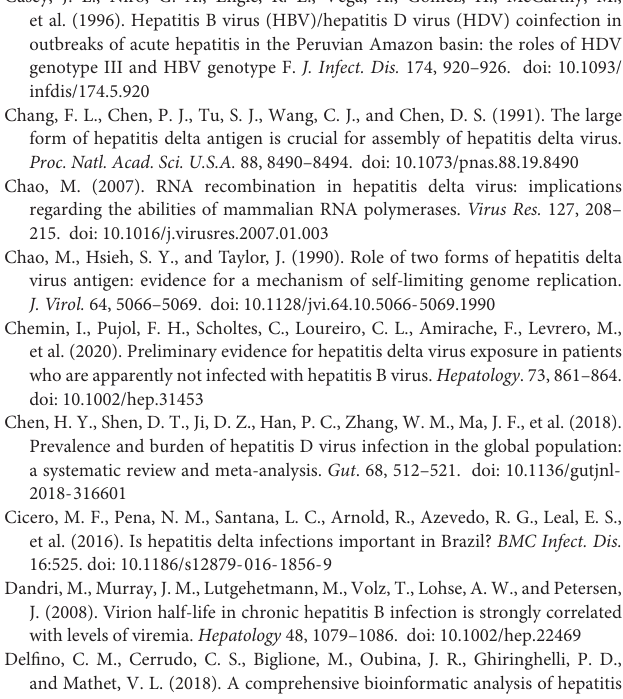
Displayed is the HDV amber/W site. The sequence ATG represents a stop codon and thus encodes for the S-HDAg, while RNA editing leads to the sequence ACC, which encodes for the L-HDAg. (C) Western blot analysis of intrahepatic S- (24 kDa) and L-HDAg (27 kDa) in two HBV/HDV-3 (left two lanes) and HBV/HDV-1 (right two lanes) infected mice. Supplementary Figure 3 | Cell death markers in mice co-infected with HBV and HDV-1cc or HDV-3cc. (A) qRT-PCR measurement of intrahepatic human caspase 8 (normalized to median of housekeeping genes hGAPDH and hRPL30) in HBV/HDV-1cc and HBV/HDV-3cc co-infected mice 9 weeks post infection compared to uninfected mice. The bar shows median levels. (B) Human serum albumin (ELISA) in HBV/HDV-1cc and HBV/HDV-3cc co-infected mice at different time-points of the experiment. Supplementary Figure 4 | Correlation of liver HDV RNA and hISG mRNA. qRT-PCR measurements of liver HDV RNA (normalized to housekeeping gene hGAPDH) and hISG15 or hCXCL10 (normalized to median of housekeeping genes hGAPDH and hRPL30) in HBV/HDV-3cc (red dots) and HBV/HDV-1cc infected mice (green dots) 9 weeks post infection. Correlations between HDV RNA and hISG15 or hCXCL10 show a p -value of p = 0.0323* (spearman r = 0.63) and p = 0.0591 (spearman r = 0.57), respectively, when HBV/HDV-1cc and HBV/HDV-3cc infected mice are analyzed together. Supplementary Figure 5 | Intrahepatic HLA ABC expression. Immunofluorescence staining of human HLA ABC (red), HBcAg (green), HDAg (turquoise) and overlays of HLA ABC with HBcAg or with HBcAg and HDAg in HBV/HDV-1cc (left) and HBV/HDV-3cc (right) co-infected mice at the end of the experiment. Nuclei are stained with Hoechst 33258 (blue). Supplementary Figure 6 | HBV in chronic HBV-infected mice simultaneously super-infected with HDV-1cc and HDV-3cc. qRT-PCR measurements of serum HBV DNA (quantification with plasmid standard) (A) and liver pregenomic HBV RNA (normalized to housekeeping gene hGAPDH) (B) in chronic HBV-infected mice simultaneously super-infected with HDV-1cc and HDV-3cc (red line or dots) compared to stable HBV mono-infected mice (black line or dots) at indicated time-points post HDV super-infection. Results are expressed as median ± range (A) , the bar shows median levels (B)